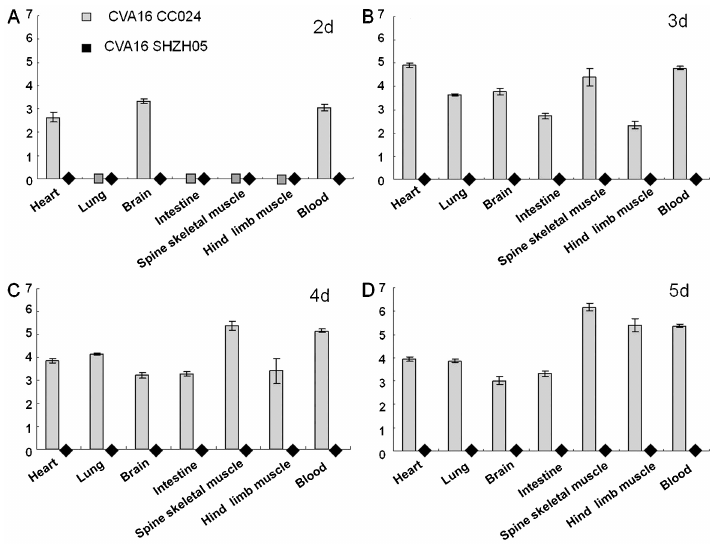
Figure 5. Mean viral loads in tissues of Coxsackievirus A16 (CVA16) CC024 or